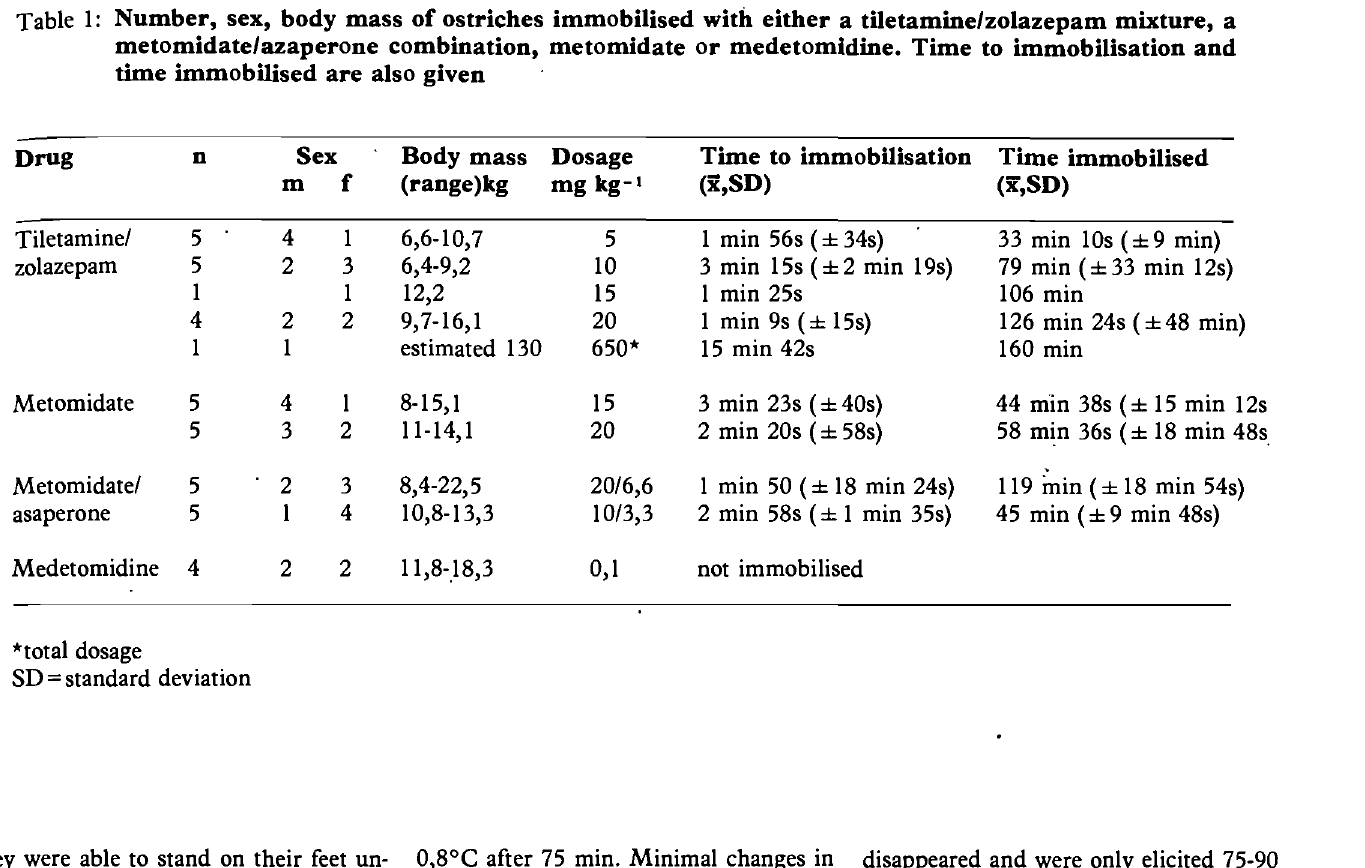
Table 1: Number, sex, body mass of ostriches immobilised with either a tiletamine/zolazepam mixture, a metomidate/azaperone combination, metomidate or medetomidine. Time to immobilisation and time immobilised are also